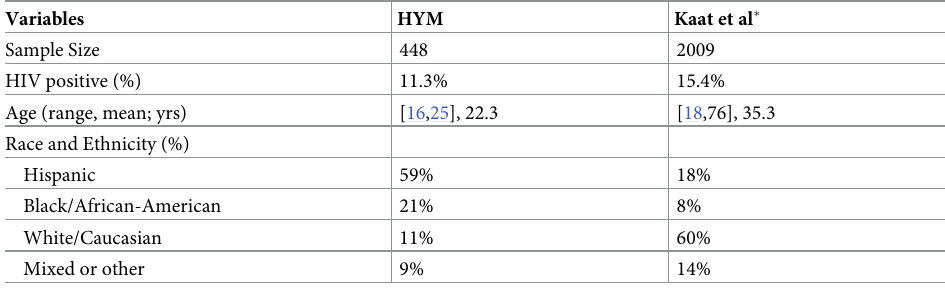
Table 1. Demographics of the HYM sample and the Kaat et al.